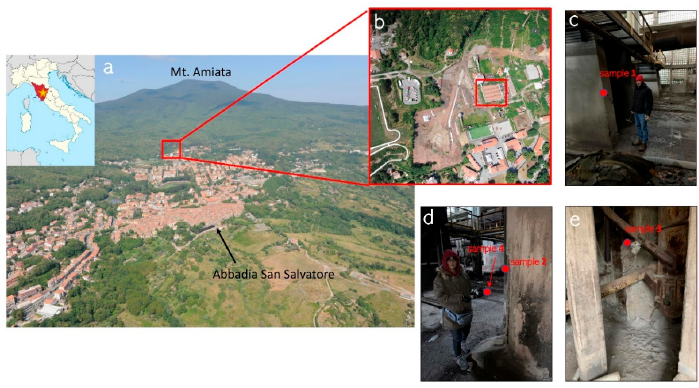
Figure 1. Location of the study area (general view and inset ( a )). The Mt. Amiata is in the background while the former mining area of Abbadia San Salvatore (Siena, Italy) is located to the north of